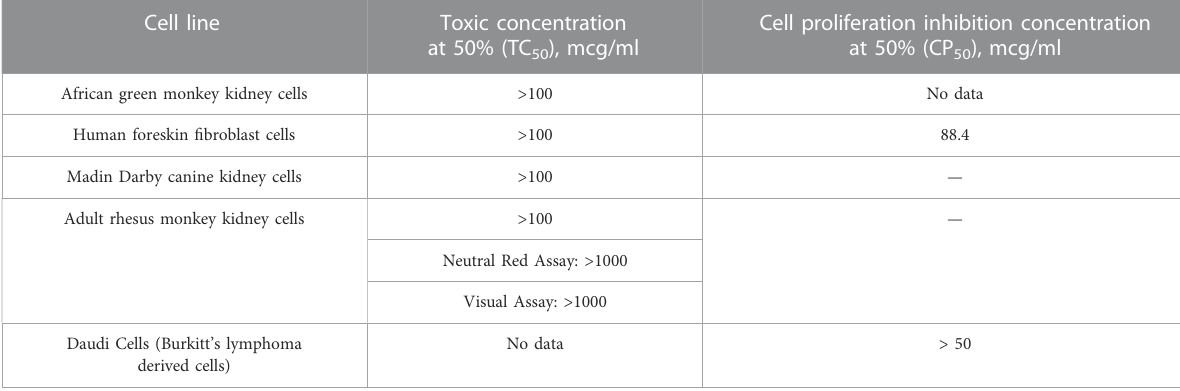
TABLE 5 Cytotoxicity assays: Humic acid with indicated cell lines (NIH, 2002).